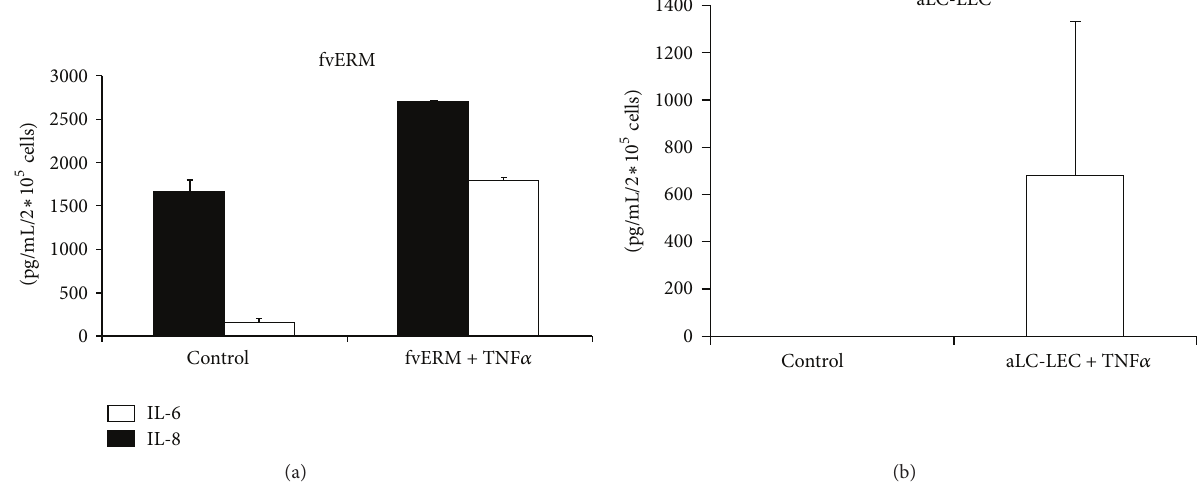
Figure 6: Cytokine secretion by aLC-LEC and fvERM outgrowing cells upon TNF 𝛼